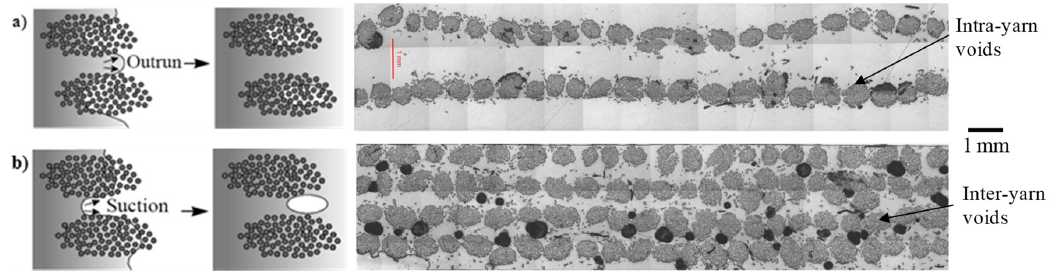
Figure 8. The complex dual-scale flow of resin in fibrous preforms can generate voids. Macro-scale flow relates to the advance of resin between yarns or tows (i.e., inter-yarn flow), while micro-scale flow relates to the penetration of resin into a yarn (i.e., intra-yarn flow). Note that permeability is also different at the two scales. For instance, ( a ) for low fibre content, due to low yarn permeability but high overall permeability, the yarn is not properly impregnated, and thus intra-yarn voids may form, while ( b ) for high fibre content, although the yarn and overall permeability are similar, capillary flow in the yarn dominates, and therefore inter-yarn voids are formed. Images reproduced by author D.U.S. from [41,63], showing jute and flax unidirectional fabrics impregnated by epoxy and polyester resins at ambient